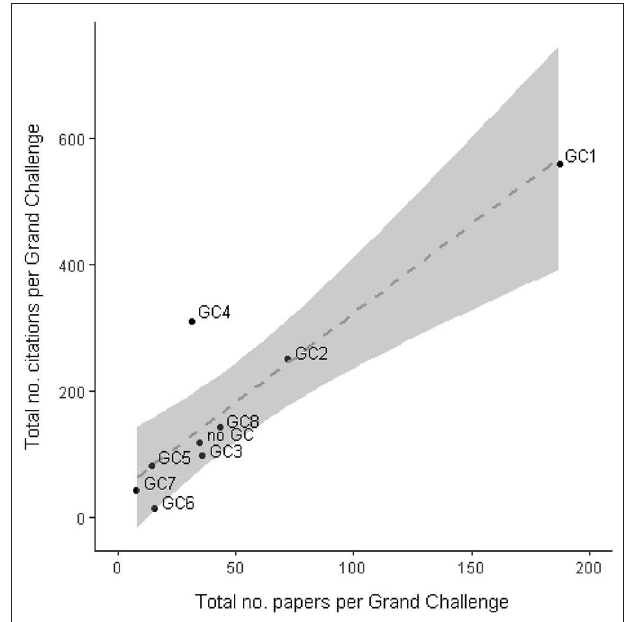
FIGURE 1 | Number of papers published in Frontiers in Marine Science, under the Marine Ecosystem Ecology topic, during the period 2014–2019. Papers are grouped per original Grand Challenge (GC1-8), as identified by Borja (2014), and plotted against the total number of citations received by all papers assigned to each Grand